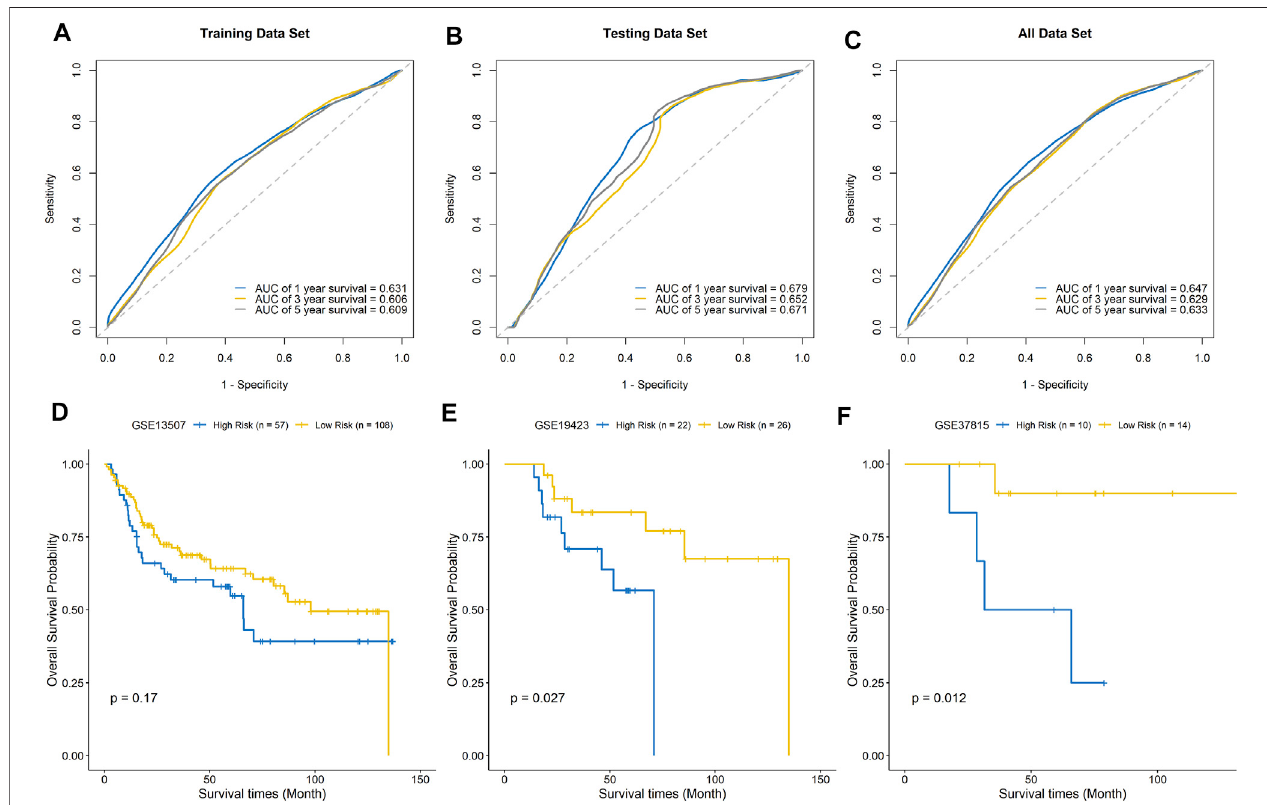
FIGURE7| Evaluationofthesignaturemodel.ROCcurvesforpredictingone-,three-,and fi ve-yearsurvivalinthetrainingset (A) ,testingset (B) ,andentiredataset (C) . External validation of the signature model using the GEO BLCA cohorts GSE13507 (D) , GSE19423 (E) , and GSE37815 (F)